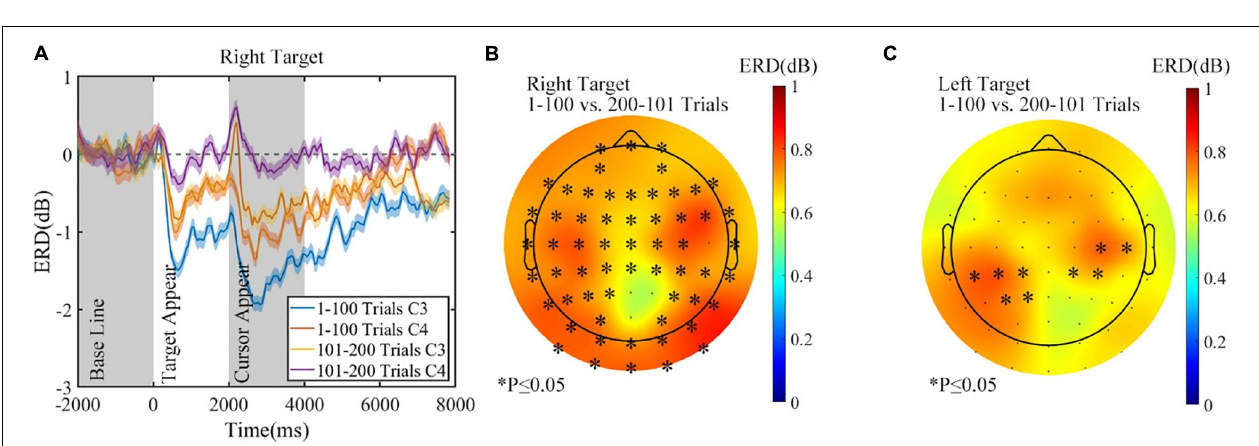
FIGURE 9 | The alpha-band (8–13 Hz) power changes (201–400 vs. 1–200 trials, feedback period) in three sessions for the left target task. (A) Alpha power changes during the no-rest session. (B) Alpha power changes during the eyes-open rest session. (C) Alpha power changes during the eyes-closed rest session. (D) Differences of band power change between the eyes-open session and the no-rest session. (E) Differences of band power change between the eyes-closed session and the eyes-open session. (F) Differences of band power change between the eyes-closed session and the no-rest session. ∗ p ≤ 0.05.